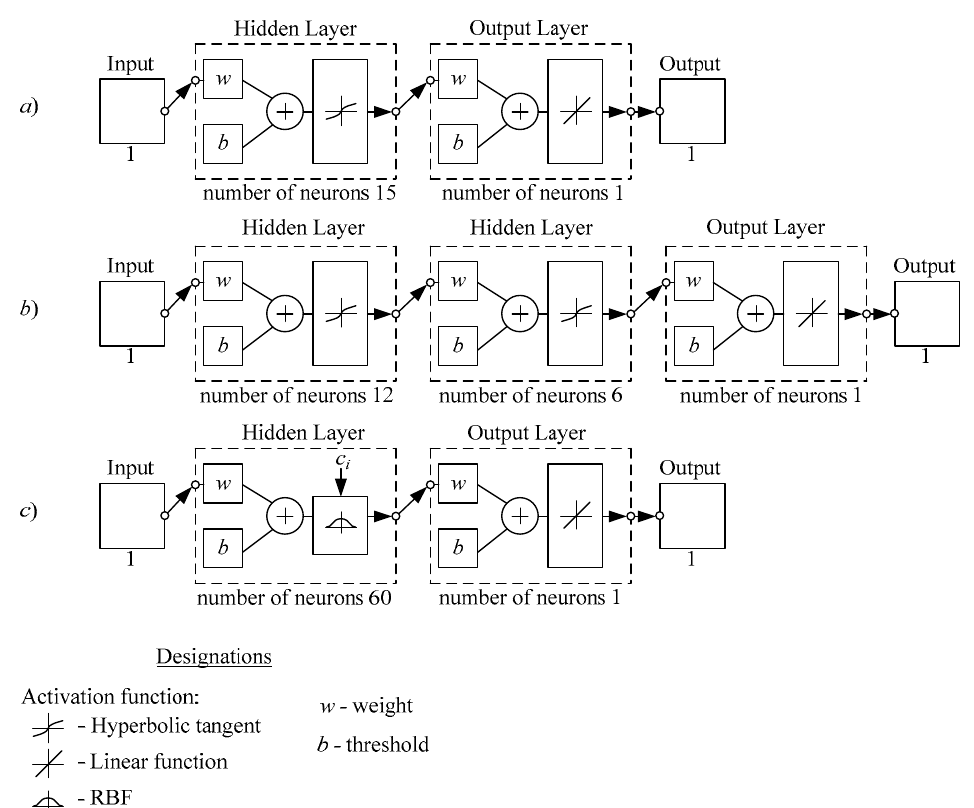
Figure 3. Artificial neural networks: multi-layer perceptron with one hidden layer ( a ), multi-layer perceptron with two hidden layers ( b ) RBF-network ( c ).